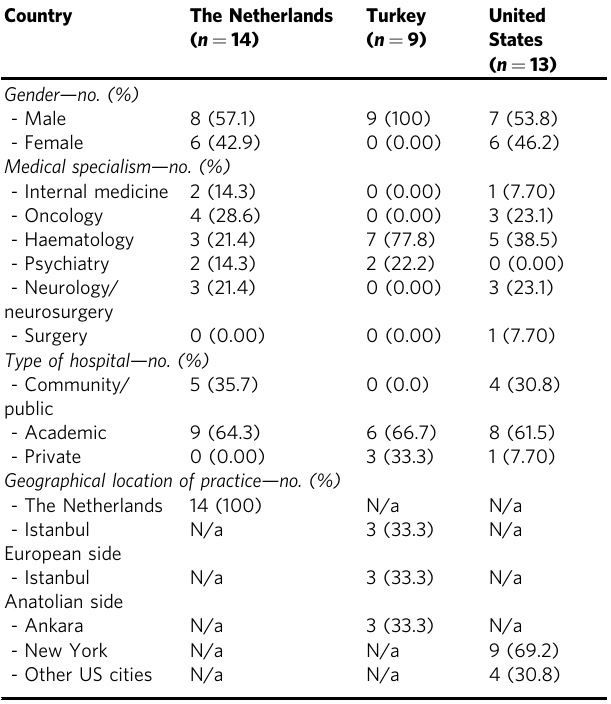
Table 4 Characteristics of the respondents.